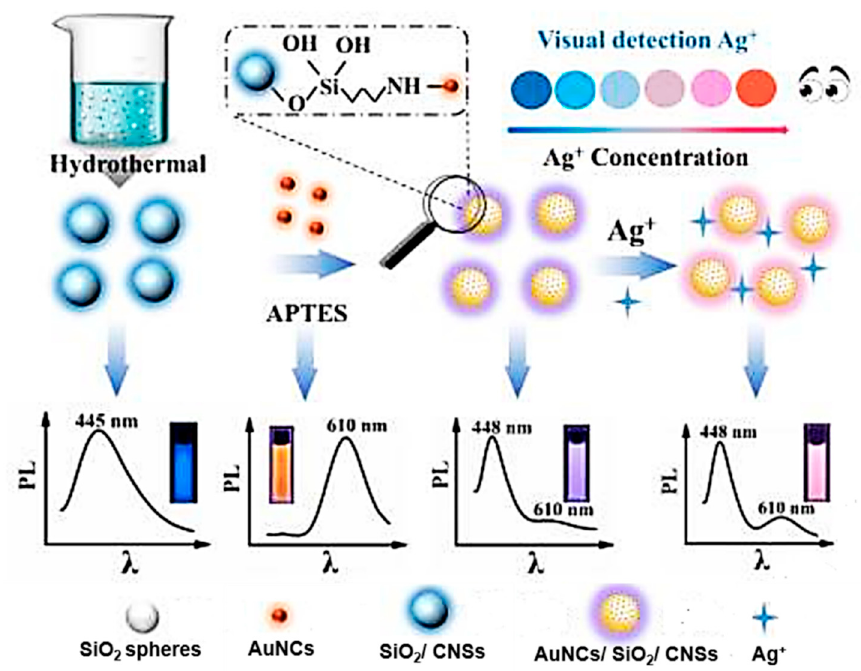
Figure 5. Schematic illustration of the composite synthesis and Ag + detection. Reprinted with permission from [20], Elsevier 2021.